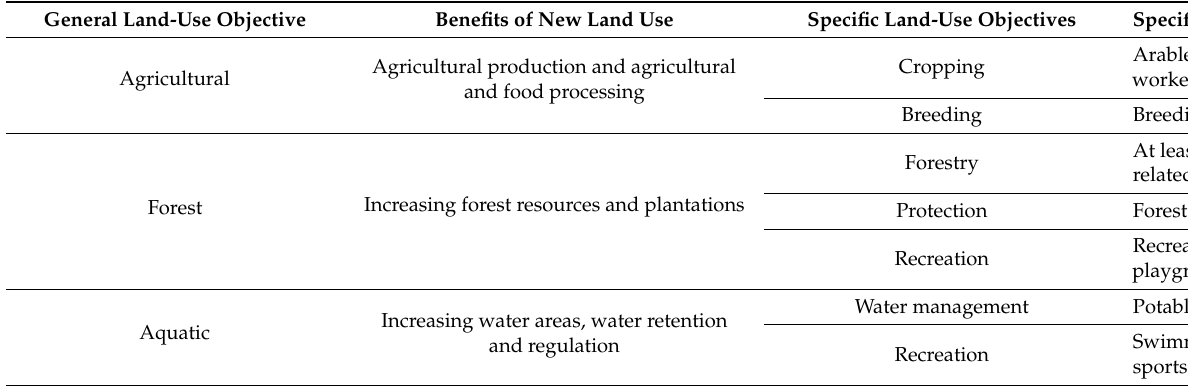
Table 1. Systematic classification of revitalization objectives for post-industrial areas